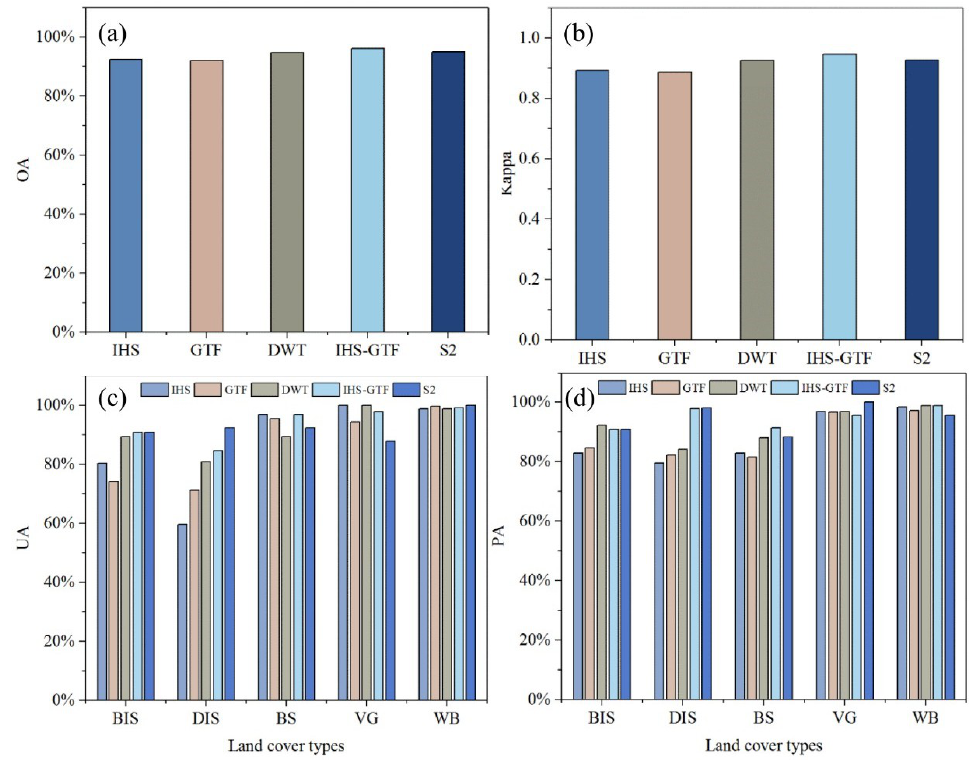
Figure 8. Comparison of classification results with different images in Site 2: ( a ) OA; ( b ) Kappa cofficients; ( c ) UA; and ( d ) PA.